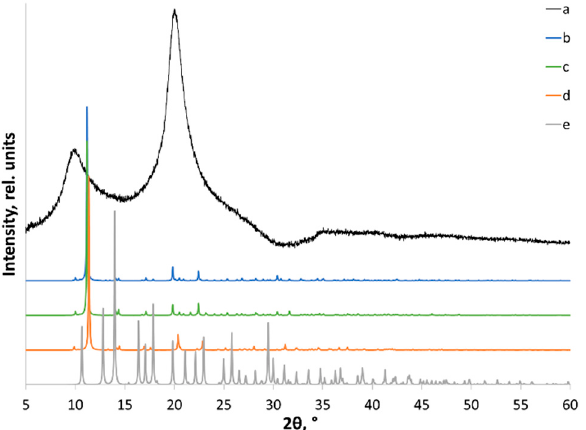
Figure 6. X-ray powder diffraction patterns of (a) initial XRD; (b) calculated from the structure reported in [38]; and (c) DFT optimized with fixed unit cell parameters; (d) DFT optimized with fixed unit cell volume; and (e) fully optimized DFT.